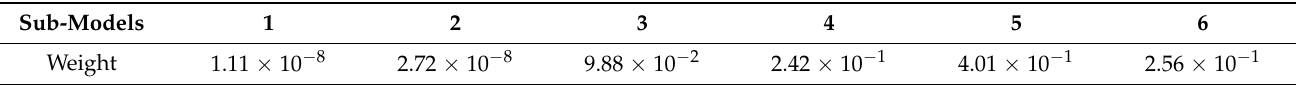
Table 4. Weight of the sub-models.